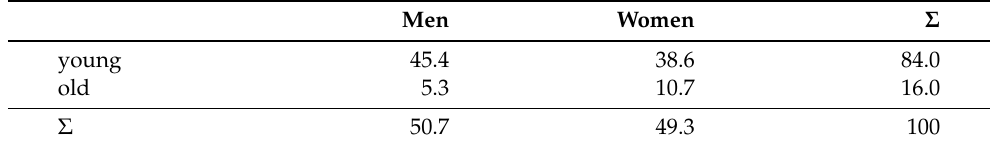
Table 1. Implicit Target